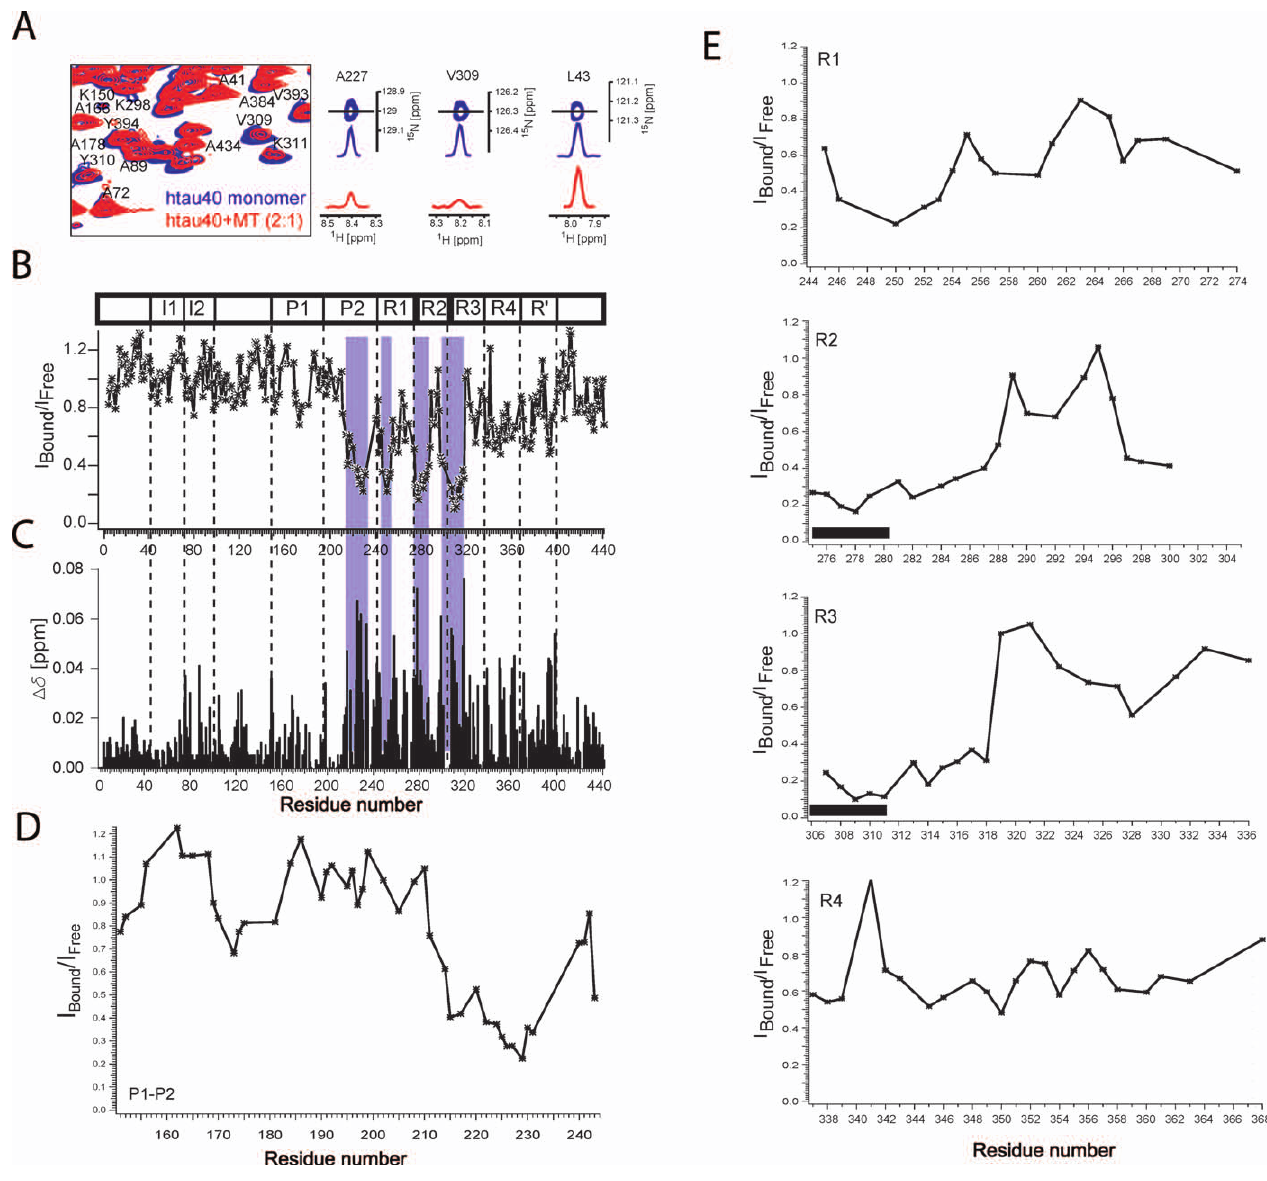
Figure 10. Interaction of Tau with MTs (A) Superposition of a selected portion of the 1 H- 15 N HSQC spectra of htau40 in the free state (blue) and in the presence of MTs (red). Resolved peaks are labelled with their assignments. The tau:tubulin heterodimer ratio was 2:1. To highlight changes in NMR signal intensities, a trace through the center (solid line) of selected peaks is shown. (B) NMR signal intensity ratios between signals observed for htau40 in the MT-bound and in the free state. Repeat boundaries are indicated by vertical dashed lines. Hot spots of binding are highlighted in blue. (C) Absolute magnitude of 15 N chemical shift changes. The estimated error based on 1 H- 15 N HSQCs of two different htau40 samples was 0.025 ppm. (D,E) NMR signals intensity ratios in the proline-rich regions (D) and in the repeat domain (E). Values were taken from (B). In (E), the position of the two hexapeptides is indicated by black